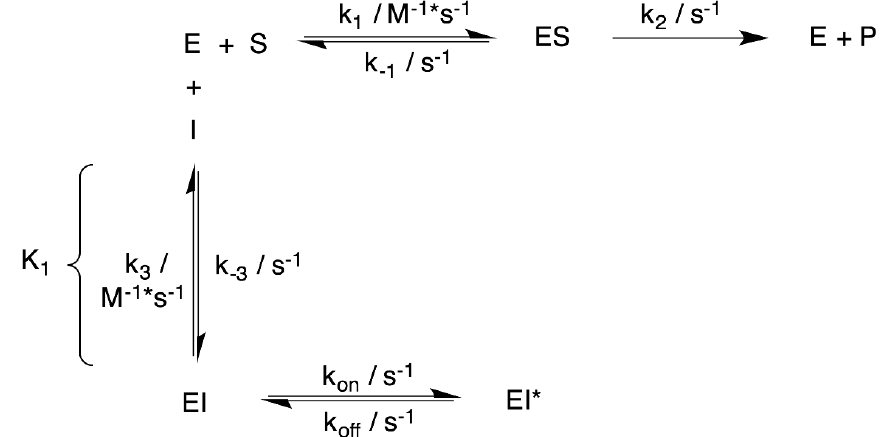
Figure 2. Michaelis Menten parameters for the determination of the mode of action with increasing compound concentra- tion. K M - and V max -values of ( A ) SATFMK and ( B ) TZD ligand 5w showed increasing and stagnating values, respectively, as expected for a competitive inhibitor. Shown data represent means and standard deviations, N =